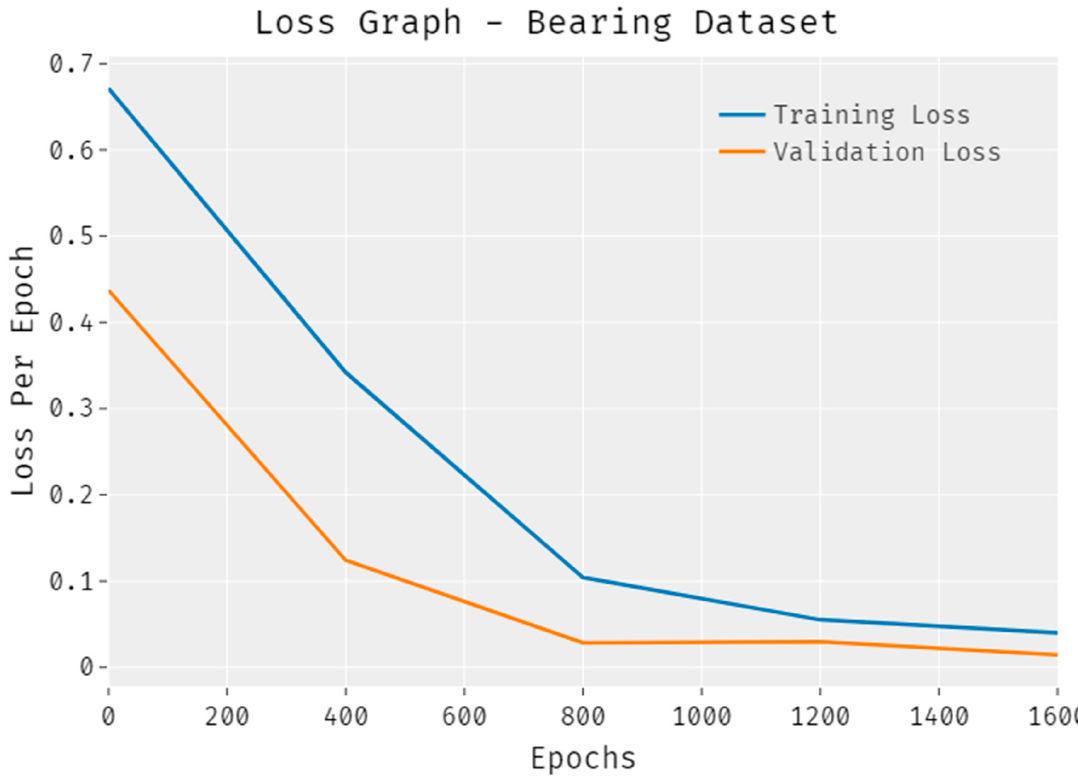
Figure 9. Loss analysis outcomes of SPOAI-FD technique under Bearing dataset